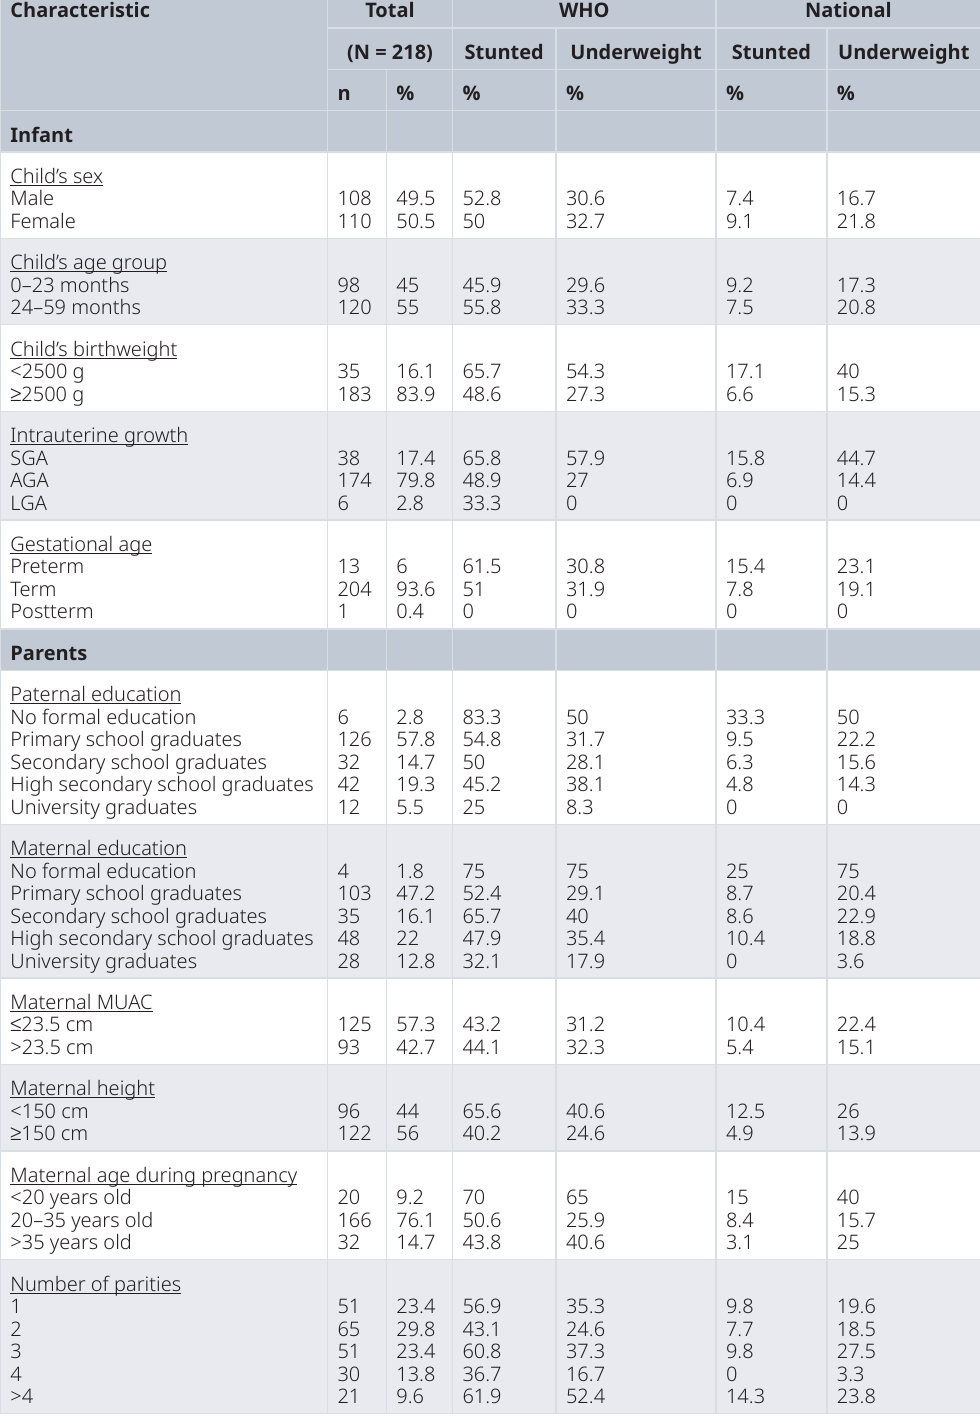
Table 2. Sociodemographic characteristics among children aged 0–59 months in Musi Sub-district. Characteristic Total WHO National (N = 218) Stunted Underweight Stunted Underweight n %